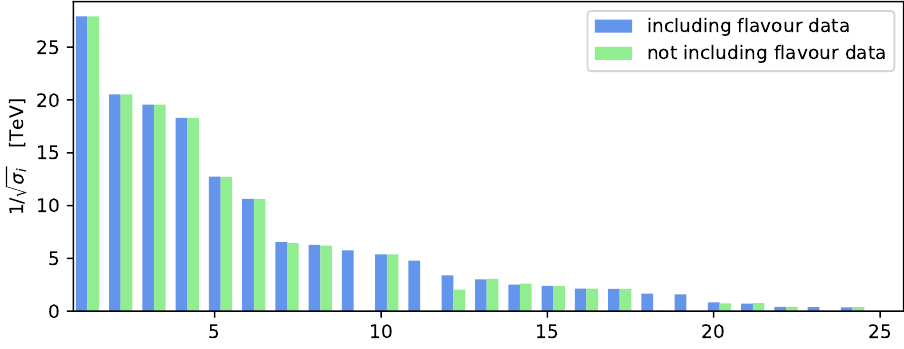
Figure 4. Comparison of the eigenvalues of the Fisher matrix, for the fit including the flavour data (blue), and the fit excluding flavour data (green). We have not plotted eigenvalues for which √ the fit including flavour data gives 1 / σ i < 250